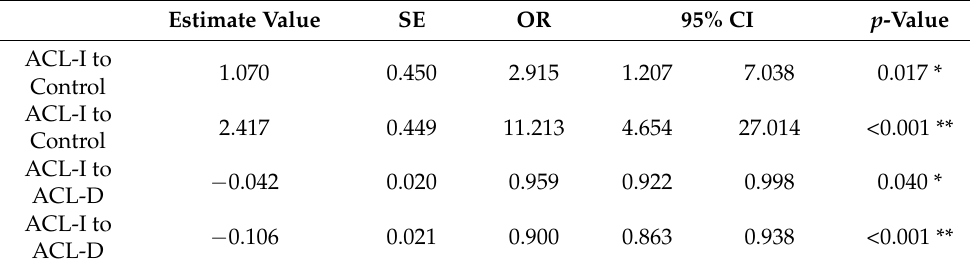
Table 6. Results of multivariate logistic regression analysis of 377 visual examination